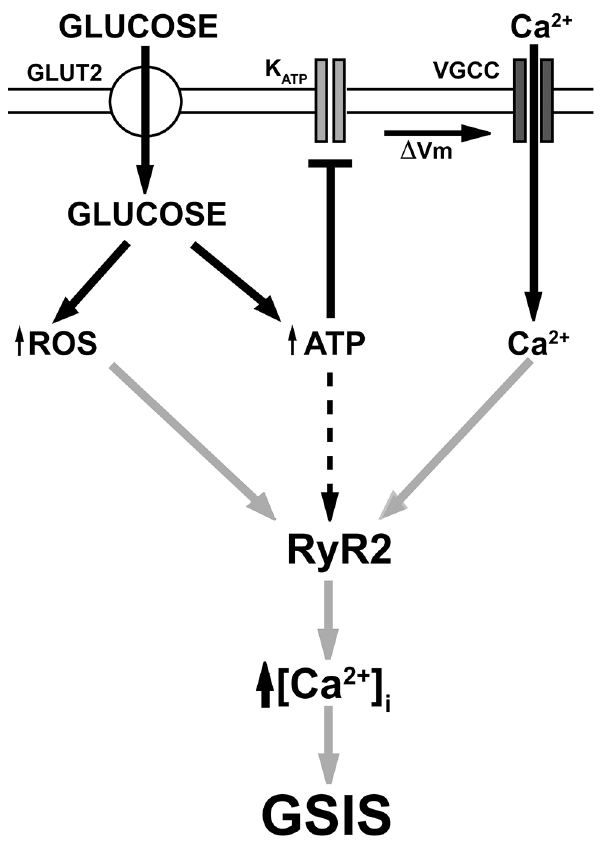
Fig 9. Schematic model of GSIS. Previous studies (thick arrows/lines) have established that an increase in extracellular glucose, the principal physiological insulin secretagogue, stimulates glucose uptake into β -cells via the GLUT-2 transporter. The ensuing accelerated metabolism of intracellular glucose stimulates ROS production and increases the cytoplasmic ATP/ADP ratio. The increase in cytoplasmic ATP promotes closure of ATP-sensitive K + channels (K ATP ) leading to membrane depolarization and activation of Ca 2+ influx through voltage-gated Ca 2+ channels (VGCC). Based on our results, we propose (gray arrows) that the ROS increase induced by glucose promotes RyR2 oxidation ( S -glutathionylation), which makes possible RyR2-mediated calcium-induced calcium release (CICR) in response to the small and localized [Ca 2+ ] i increase produced by Ca 2+ influx. The glucose-induced ATP increase may also contribute to stimulate CICR mediated by oxidized RyR2 channels (broken arrow). The subsequent [Ca 2+ ] i increase promotes insulin